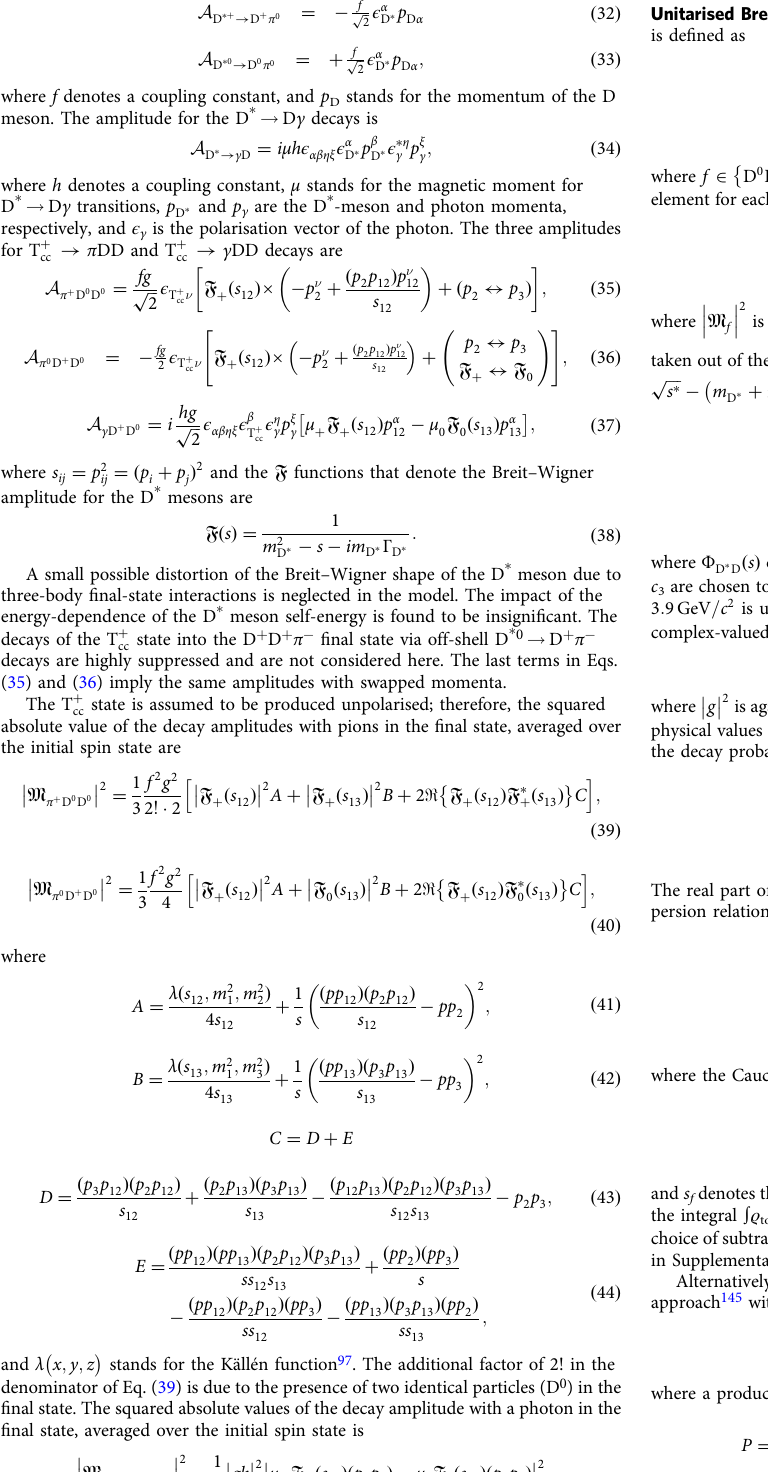
matrix G and the self-energy function Σ ( s ) from Eqs. (54) and (56), are related as